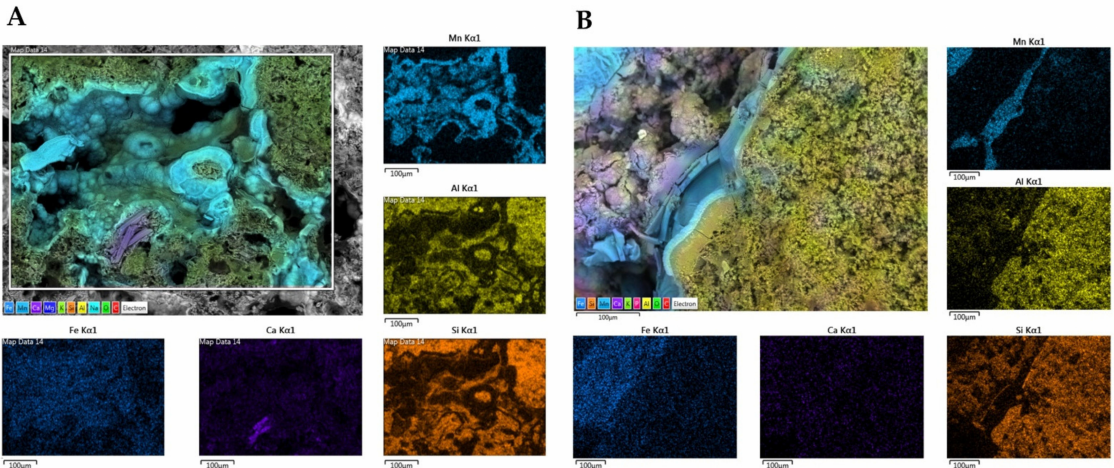
Figure 8. Energy Dispersive X-ray Spectroscopy (EDS) maps of main elements obtained for samples S1 ( A ) and S3 ( B ). The distribution of the single elements (Fe, Ca, Si, Al, and Mn) are provided in subfigures. Scale bars (100 µ